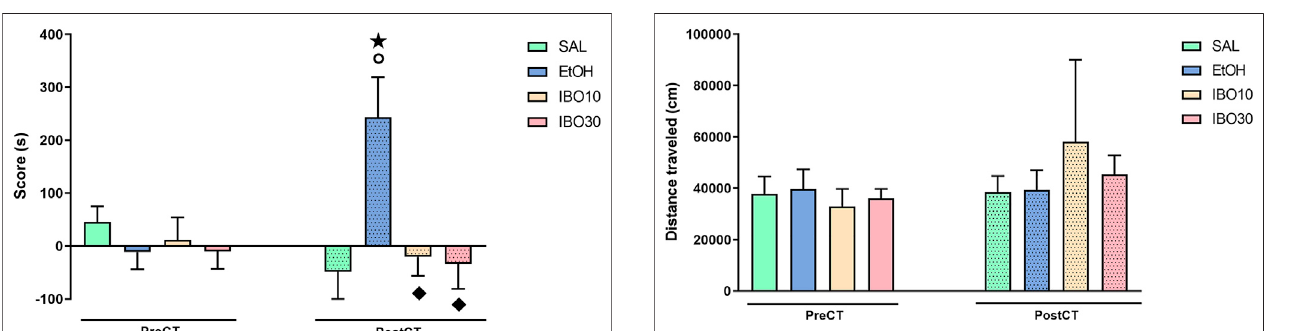
FIGURE2 | Effects ofconditioning withsaline (SAL,i. p.), ethanol (EtOH, 1.8 g/kg, i. p.) or ibogaine (IBO, 10 or 30 mg/kg, oral administration) in the conditioned place preference (CPP) paradigm. CPP score (difference between the time spent in the EtOH/IBO- and in the saline-paired